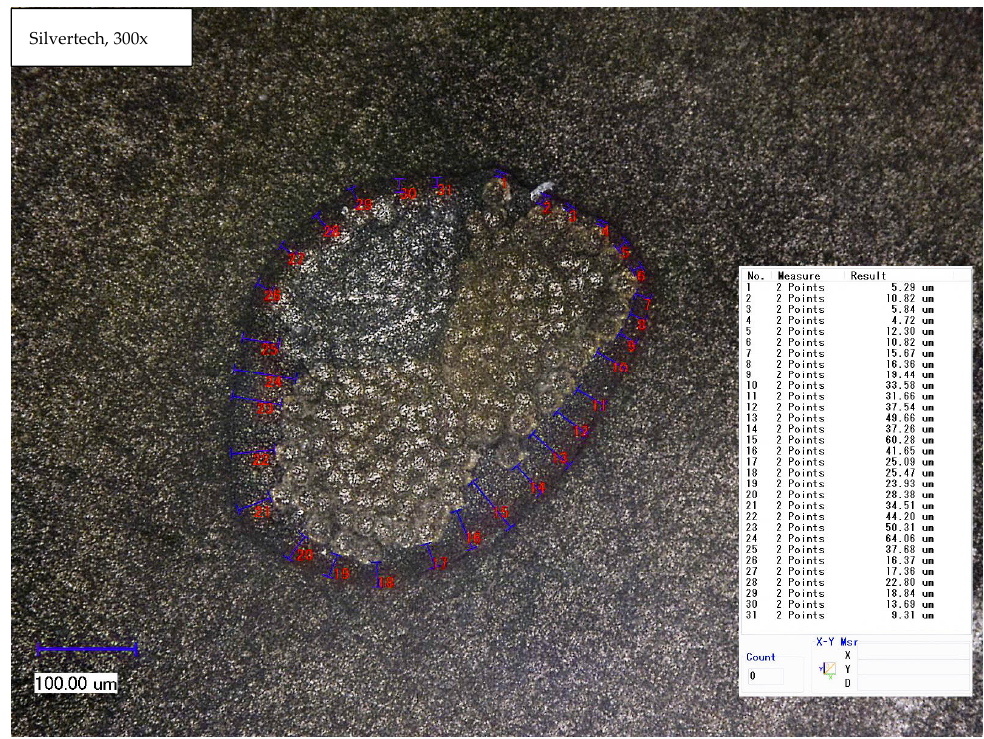
Figure 5. Light microscopic measurement of the layer thickness of the coating exemplarily here at the Silvertech substrate. Table 2. Coating thickness calculated by averaging light microscopic cross-section measurements of the coating.